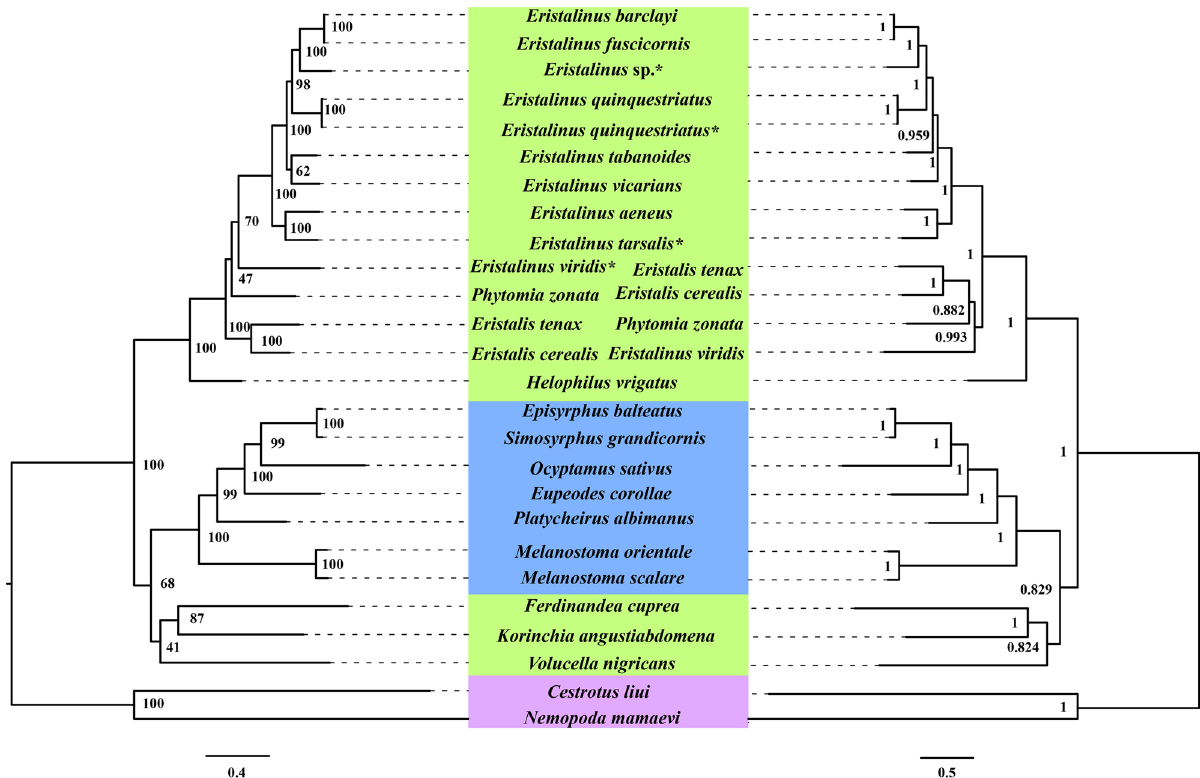
Figure 8. Phylogenetic trees of Syrphidae based on the PCGRNA dataset using maximum likelihood (ML, left) and Bayesian inference (BI, right) methods. “Bootstrap support” (ML) and “posterior probabilities” (BI) are indicated at their nodes respectively. The species sequenced in this study were marked with * after the species name. The image was mainly predicted by IQ-TREE (http:// iqtree. cibiv. univie. ac. at/) and MrBayes in CIPRES webserver (https:// www. phylo. org/ porta l2/ login !input. action), drawing with Adobe Illustrator